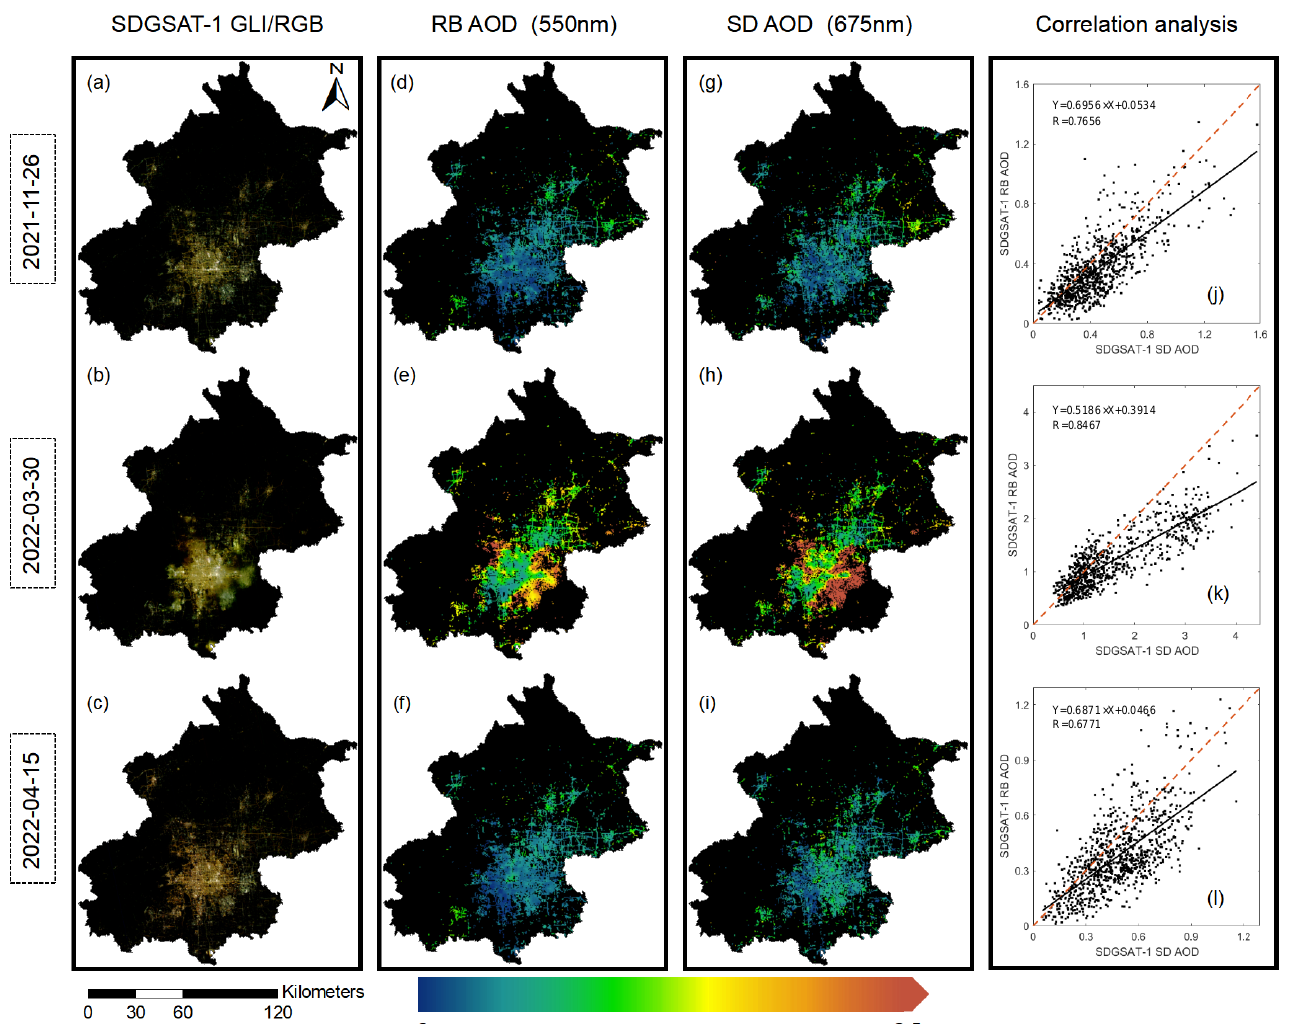
Figure 6. Spatial patterns of AOD in Beijing derived from SDGSAT-1/GLI images. Each row lists AOD results from RB and SD method under three typical weather conditions on 26 November 2021, 30 March 2022, and 15 April 2022, respectively. ( a – c ) are the night color low-light level images of SDGSAT-1/GLI, ( b – f ) are the AOD results obtained by inversion of the RB algorithm, ( g – i ) are the AOD results obtained by inversion of the SD algorithm, and ( j – l ) are the correlation analyses of AOD values obtained by SD and RB inversion algorithms.